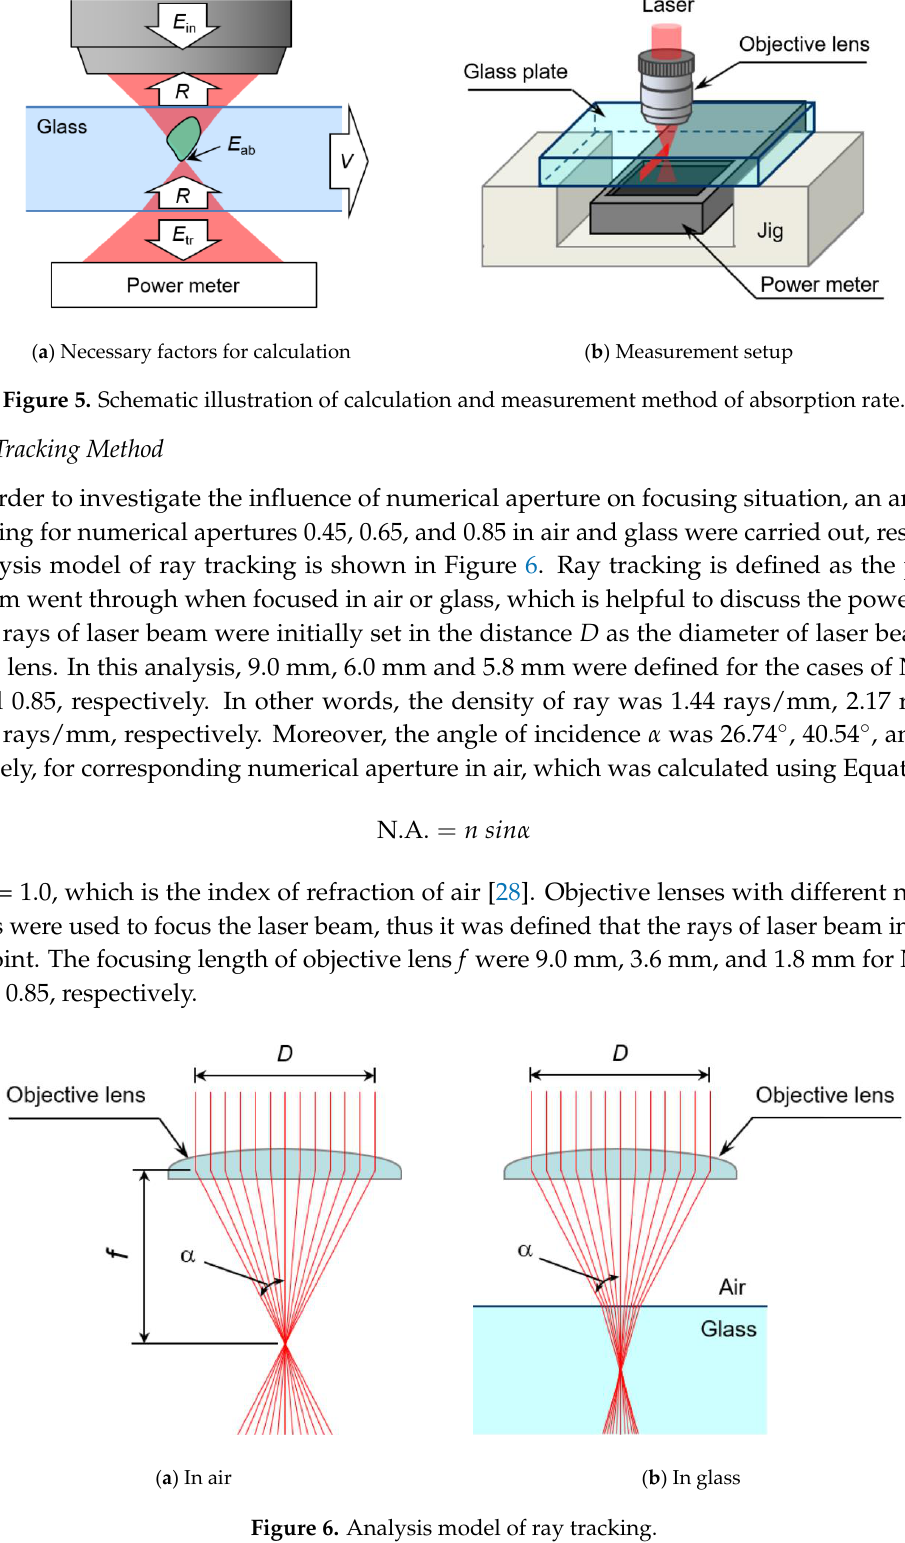
Figure 6. Analysis model of ray tracking.